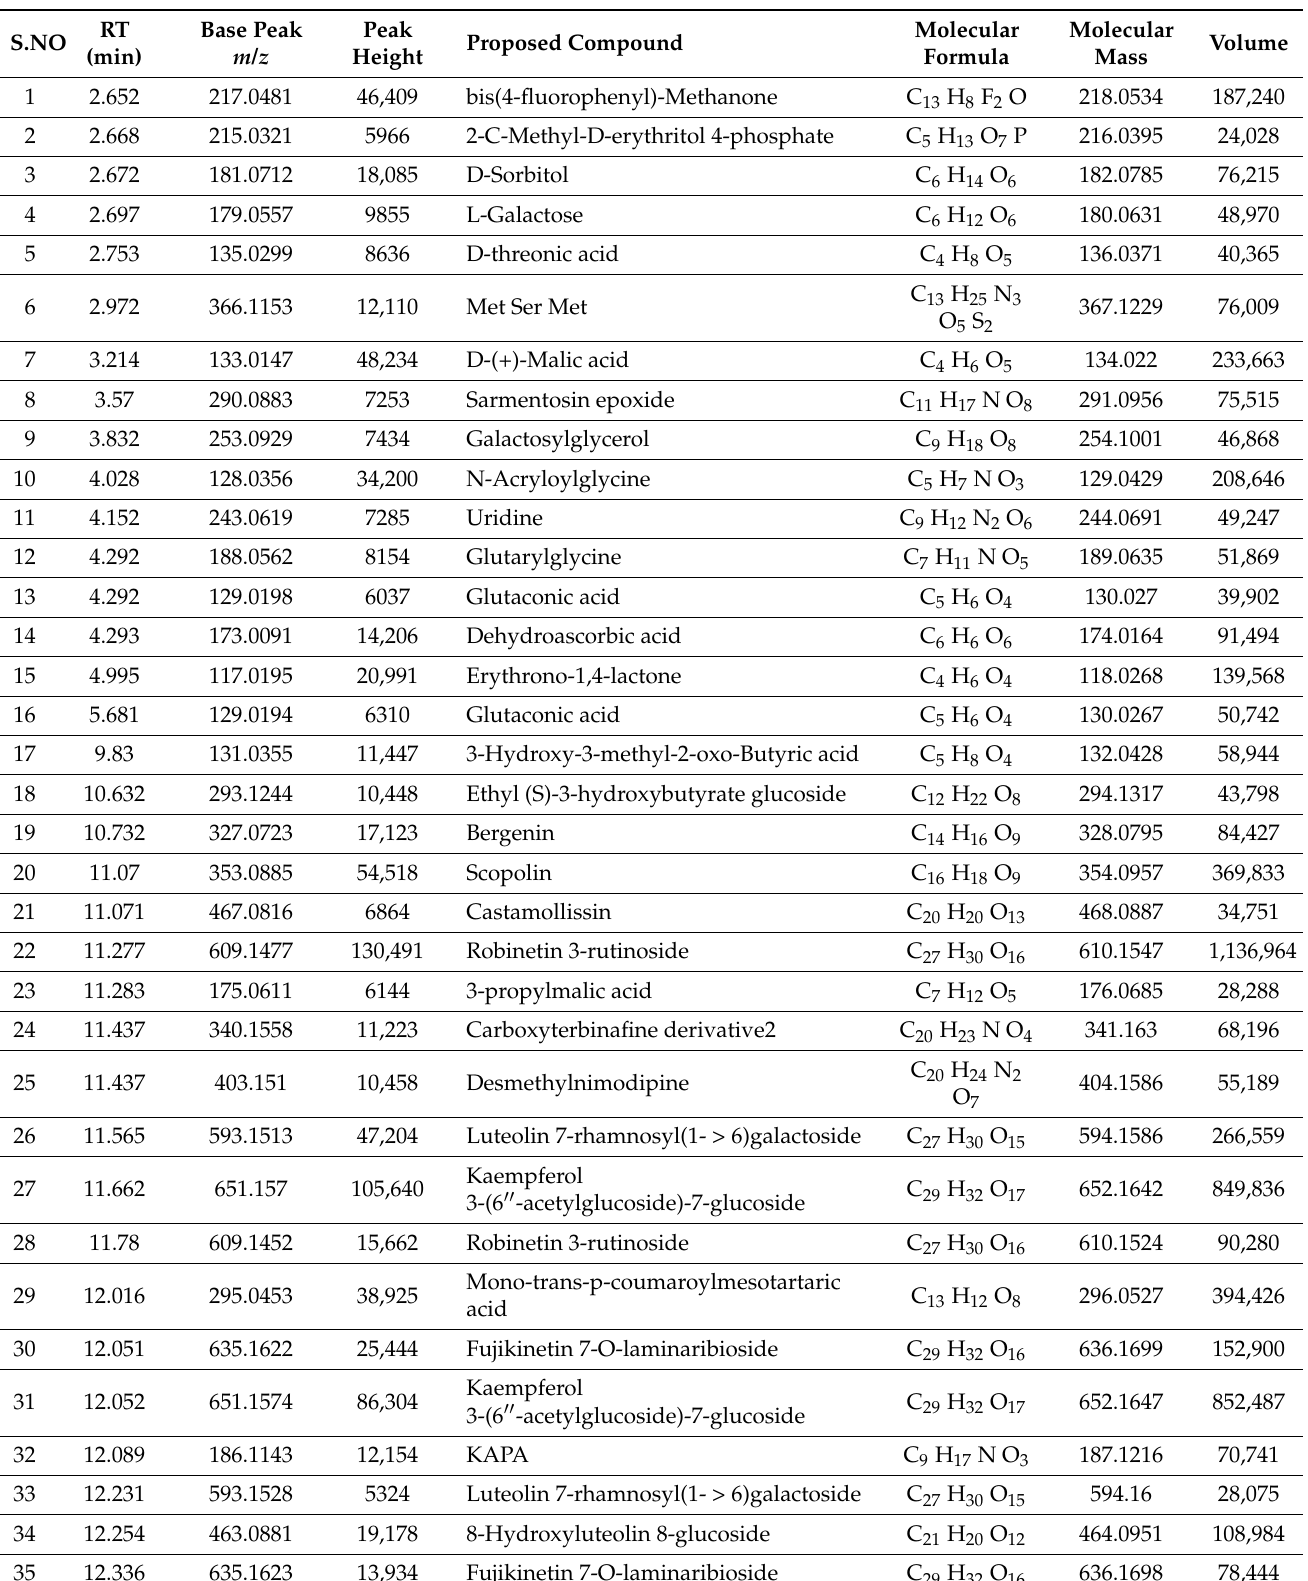
Table 1. List of compounds identified by LC-MS analysis of